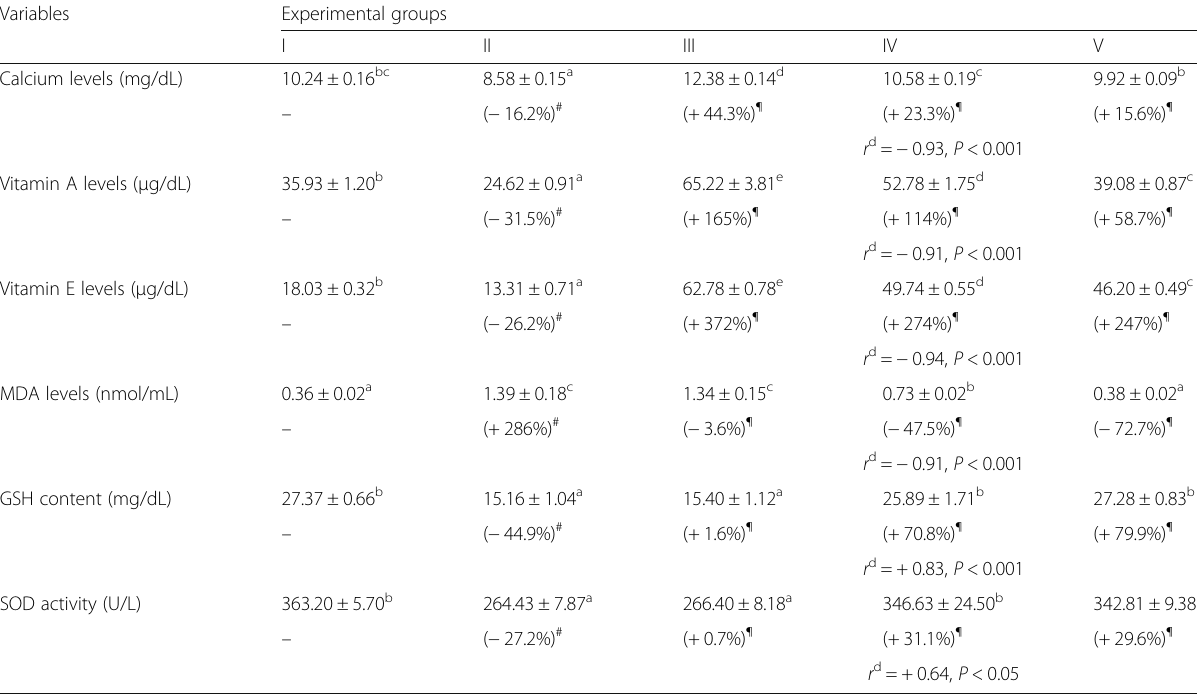
Table 7 The serum levels of calcium, vitamins A and E, and malondialdehyde (MDA) as well as erythrocyte content of glutathione (GSH) and activity of Superoxide dismutase (SOD) of all the experimental groups, at the end of the experiments